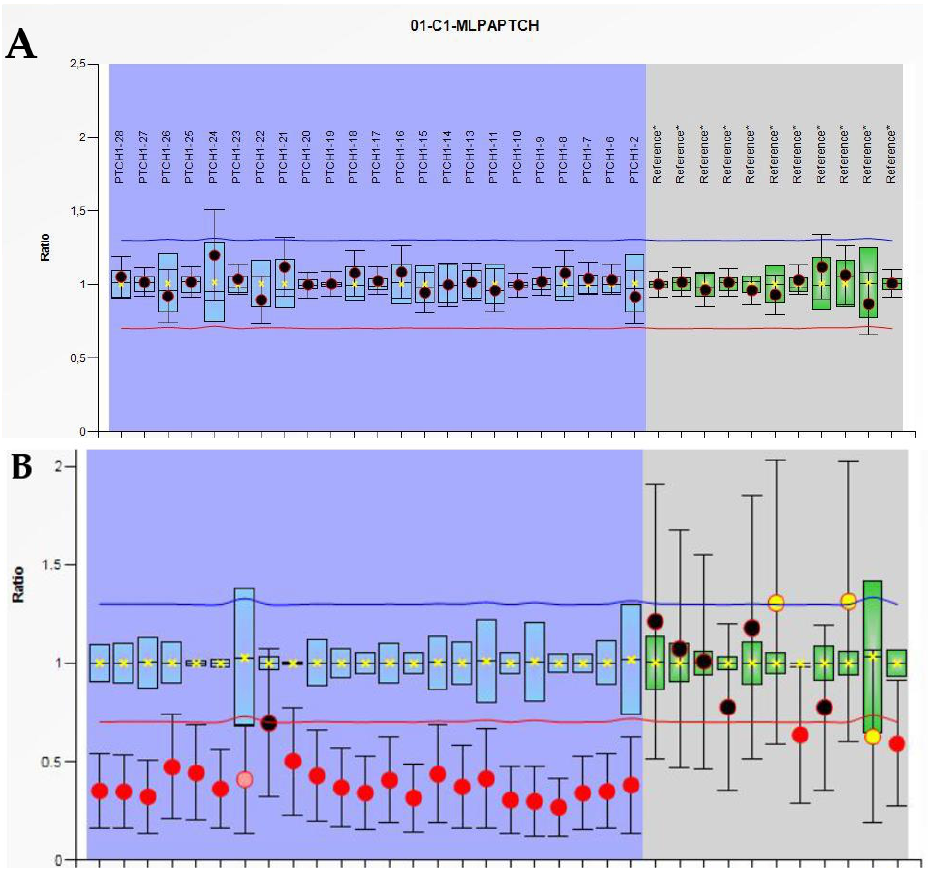
Figure 1. Representations of wild type ( A ) and allelic PTCH1 deletion ( B ) in the BCC of patient SG12 obtained from multiplex ligation-dependent probe amplification (MLPA) analysis. The blue and green boxes represent the interquartile range of normal (N = 3) values for 23 PTCH1 exons and 11 reference non- PTCH1 probes, respectively, of the P067-B1 PTCH1 kit. The blue and red lines represent duplication and deletion cut-off values, respectively. Patient median values for each probe and their standard deviations are shown as circles filled with red (abnormal), yellow (indeterminate), or black (normal).